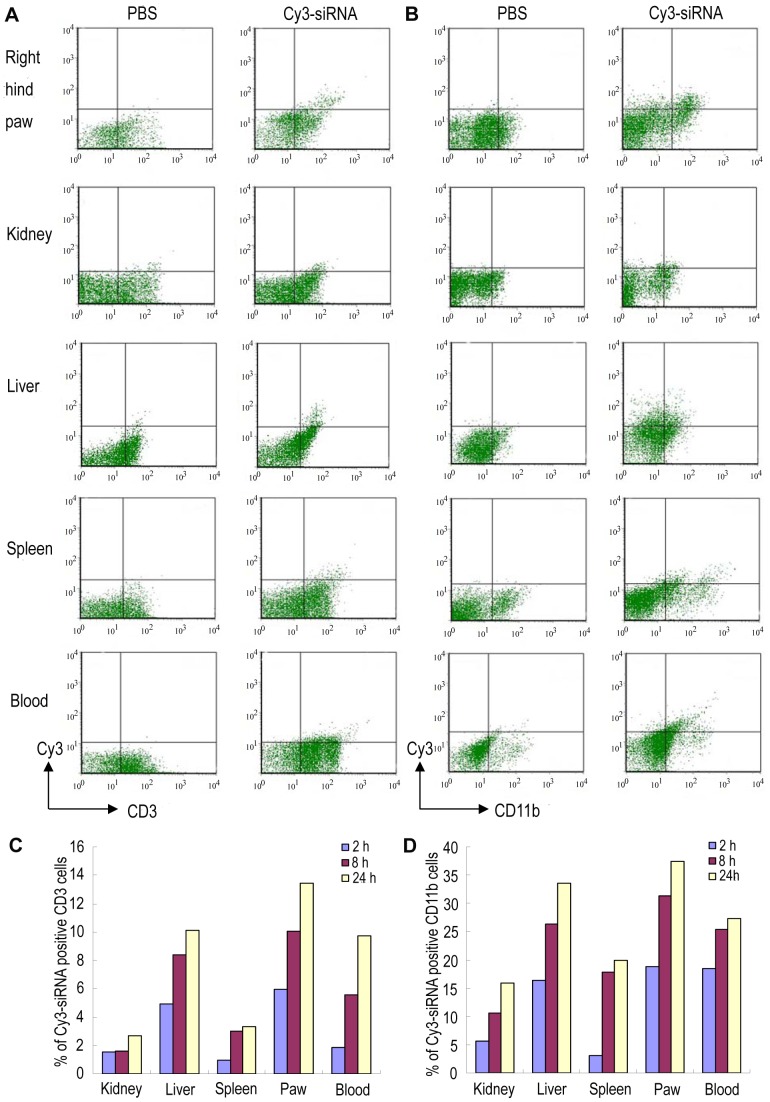

In vivo cellular uptake of siRNA polyplexes after single systemic administration.Arthritis rats were injected intravenously with 0.3/kg Cy3-siRNA formulated with PEI. The rat receiving phosphate buffered saline (PBS) was used as control. Cellular uptake of the Cy3-siRNA was evaluated by flow cytometry 2, 8, and 24 hours after injection using anti-CD3 and anti-CD11b mAbs. (A,B) Representative flow cytometry dot plots at 24 h. (C,D) Histograms showing percentages of Cy3-siRNA uptake within the gated CD3 or CD11b positive cells. Each value is an average of two determinations from two independent experiments. Data are representative of two independent experiments.